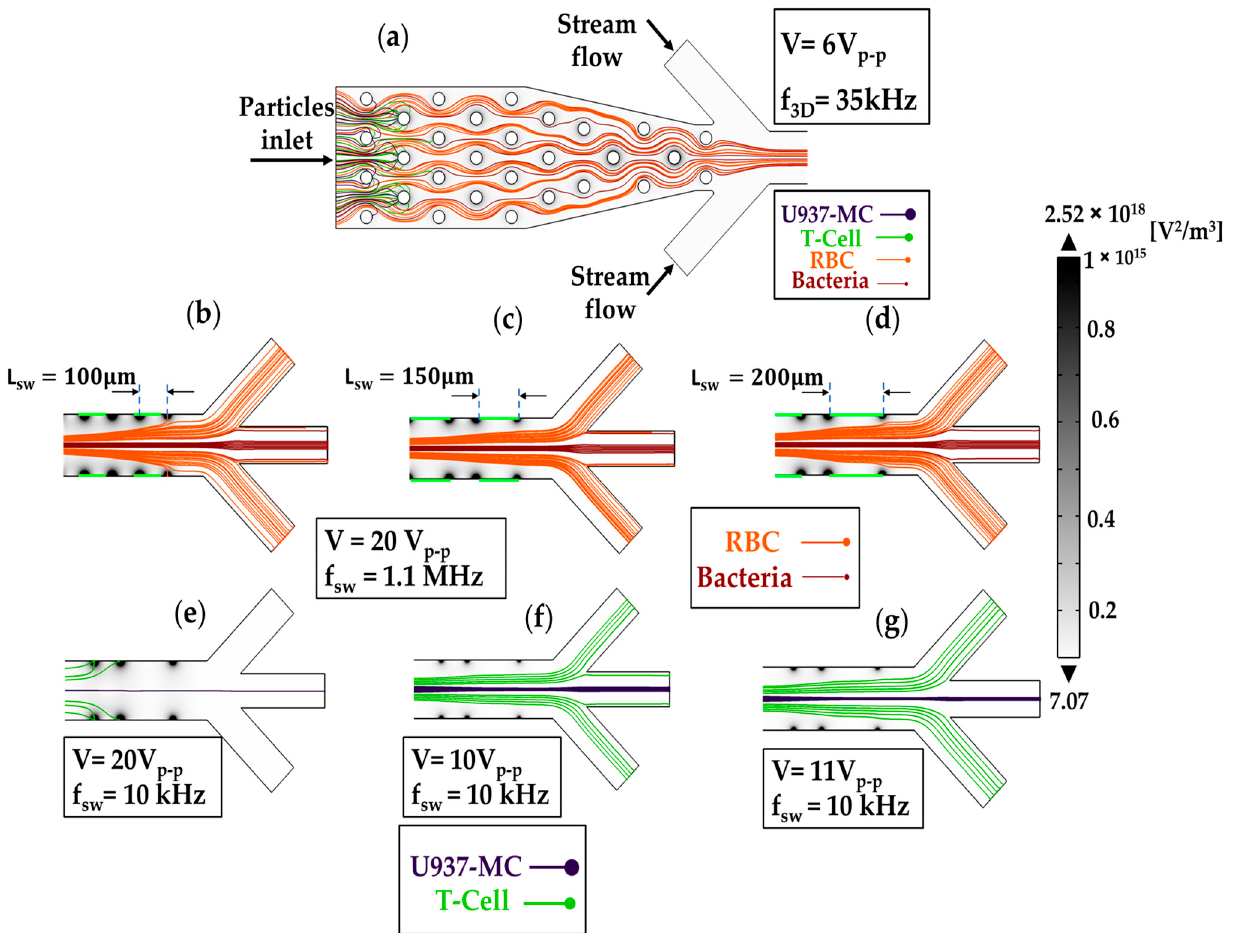
Figure 8. Cell trajectory in di ff erent steps of separation in Section III. ( a ) The cells of Group 1 are trapped by the 3D electrodes, and cells of Group 2 pass Section I. ( b – d ) Separation of cells in Group 1 by di ff erent sidewall electrode sizes. ( e – g ) Separation of cells in Group 2 under di ff erent applied voltages.